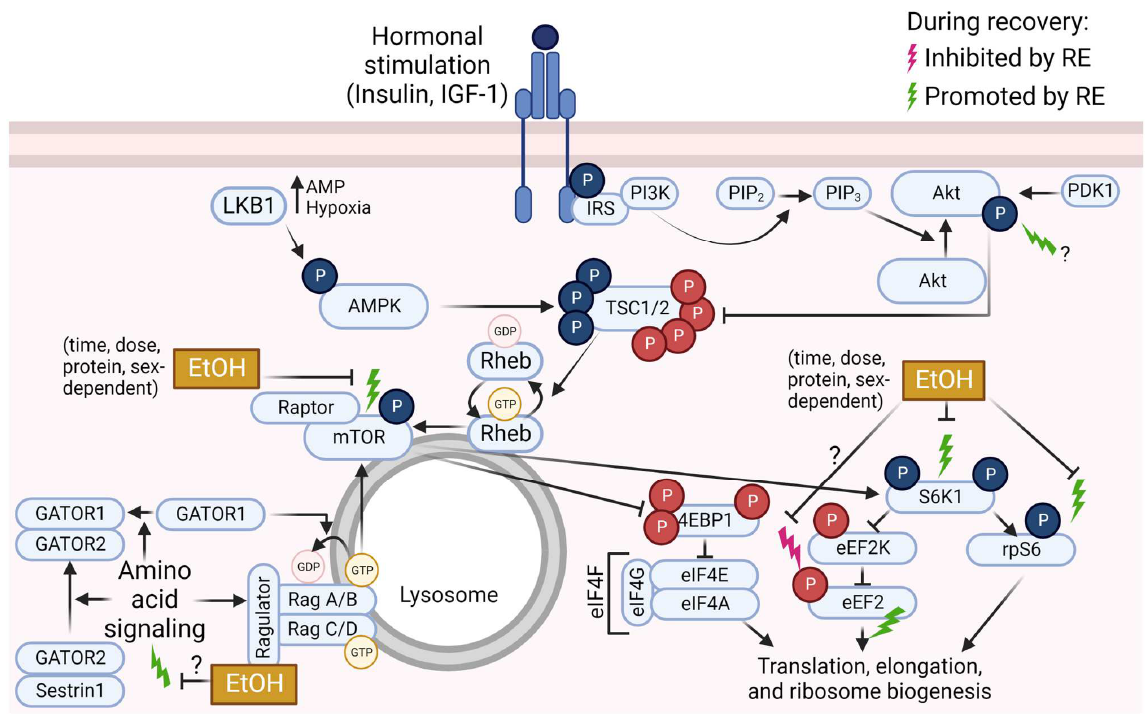
Figure 2. Overview of mammalian/mechanistic target of rapamycin (mTOR) signaling pathway events that are inhibited (pink lightning bolt) or promoted (green lightning bolts) by resistance exercise (RE), and known or potential impacts of ethanol (EtOH) on these changes. Phosphate groups (P) in red indicate inhibitory events; P in blue indicate activating events. Abbreviations: 4E binding protein 1 (4EBP1), AMP-activated protein kinase (AMPK), diacylglycerol kinase (DGK), diacylglycerol (DAG), eukaryotic elongation factor (eEF), eukaryotic initiation factor (eIF), GAP activity toward Rags (GATOR), insulin receptor substrate (IRS), insulin-like growth factor-1 (IGF-1), liver kinase B1 (LKB1), p70 S6 kinase 1 (S6K1), phosphatidic acid (PA), phosphatidylcholine (PC), phosphatidylinositol (4,5)-bisphosphate (PIP2), phosphatidylinositol (3,4,5)-trisphosphate (PIP3), phosphoinositide 3-kinase (PI3K), phospholipase D (PLD), protein kinase B (Akt), pyruvate dehydrogenase kinase 1 (PDK1), Ras homolog enriched in brain (Rheb), ribosomal protein S6 (rpS6), tuberous sclerosis complex (TSC). Created using Biorender.com (accessed on 13 December